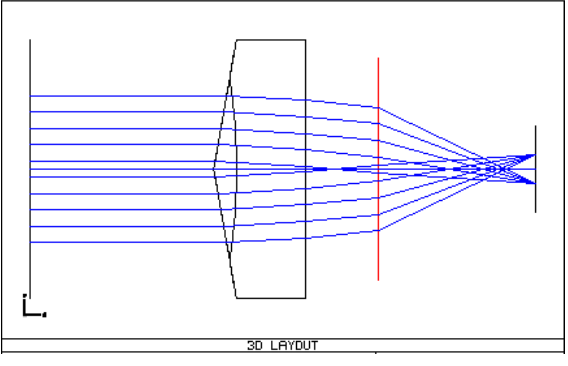
Figure 6. First pyramid design in zemax. The red line is the equivalent lens corresponding to the